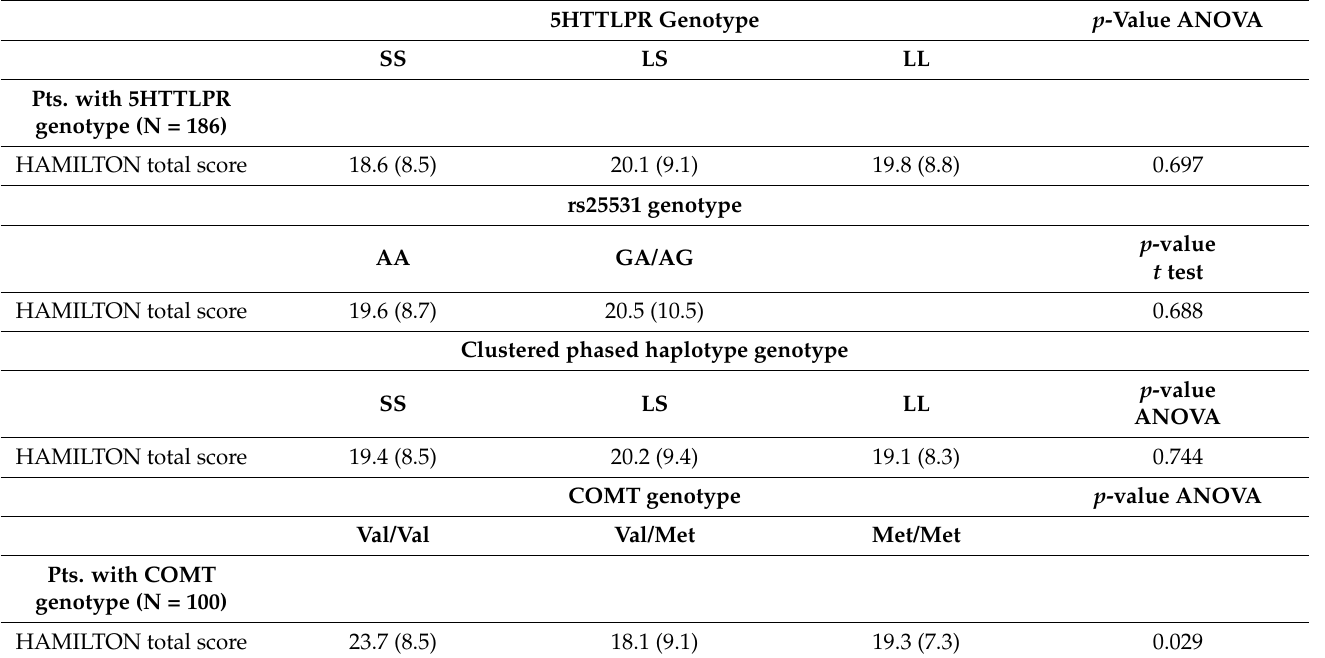
Table 4. Mean score differences in depression (HAMILTON) among the 5HTTLPR, rs25531, the clustered phased haplotype, and the COMT genotypes.